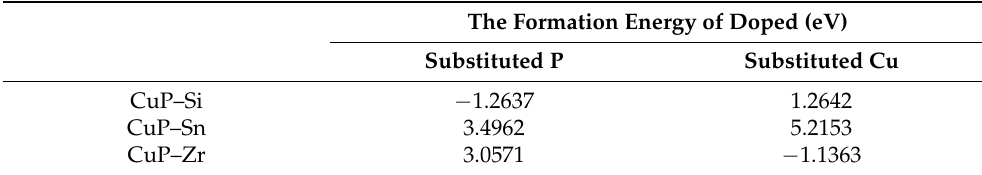
Table 3. The formation energy of doped Si, Sn, and Zr atoms in the bulk Cu 3 P. The Formation Energy of Doped (eV) Substituted P